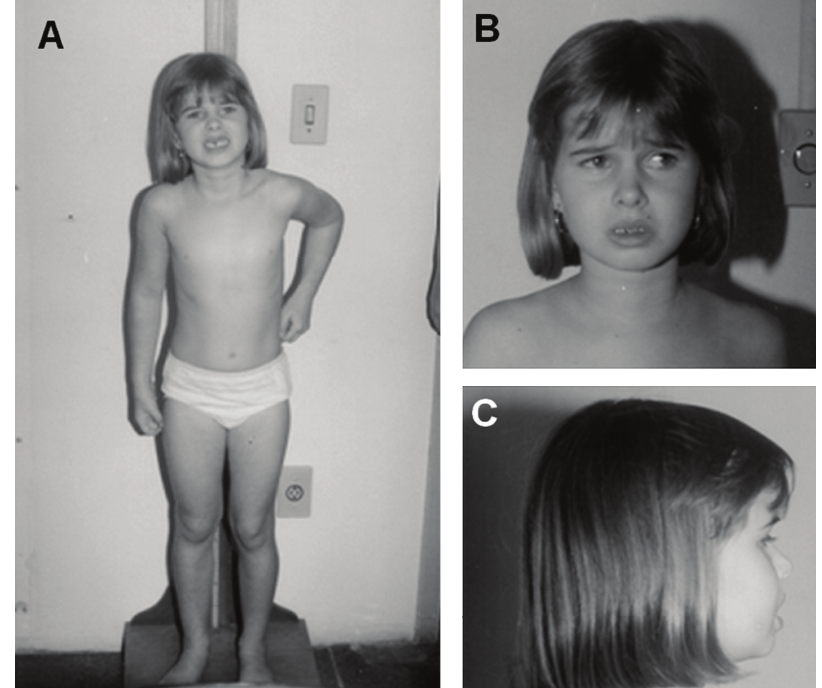
Figure 1: The patient at 6 yo (A), face (B), and profile